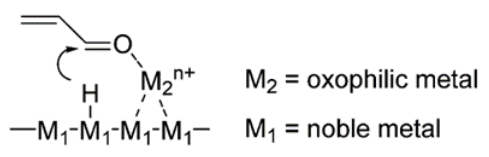
Figure 9. The proposed adsorption structure of furfural on the catalyst surface.